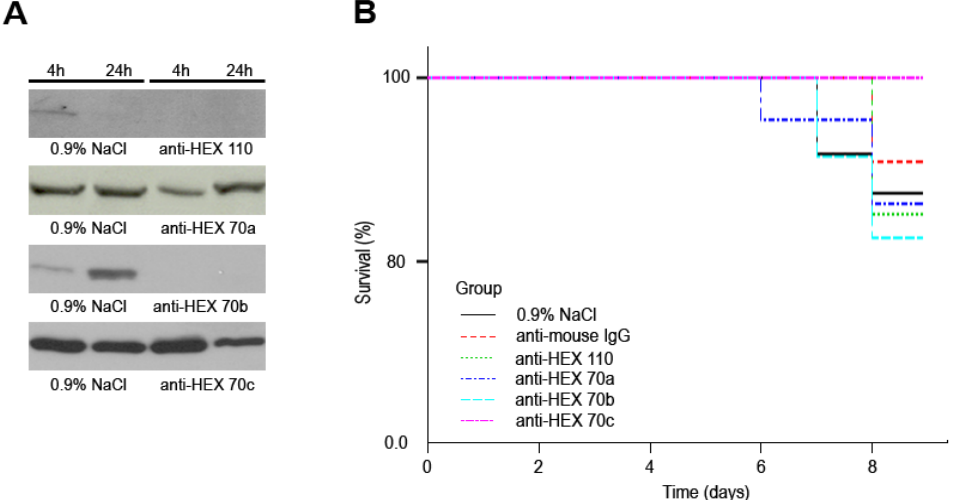
respective antibodies diluted in 0.9% NaCl. Control groups were injected with 0.9%